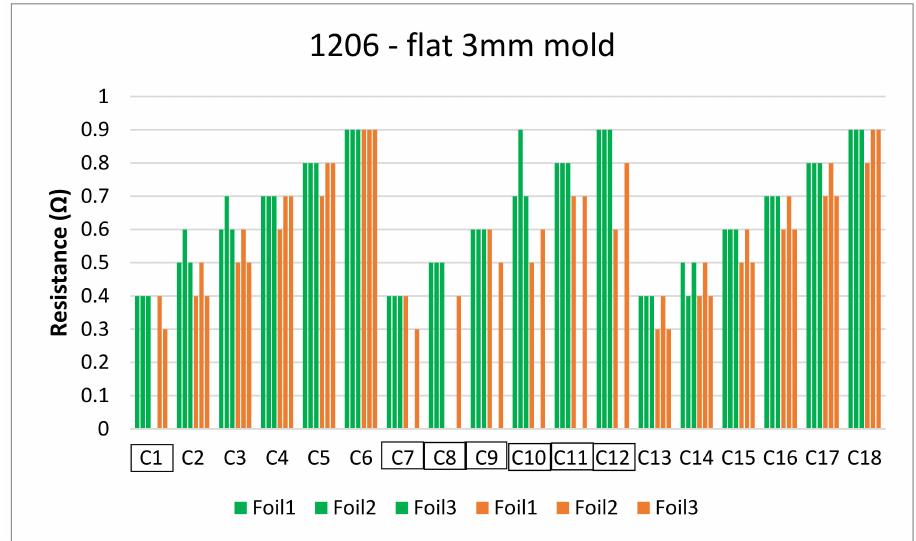
Figure 47. Resistance measurements for flat mold-3 mm for 1206